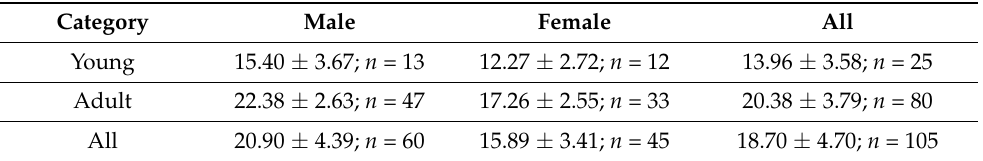
Table 2. Mean gazelle body weight, in kg ( ± SD), and the number of carcasses collected, by sex and age-class; for five individuals, weight records were